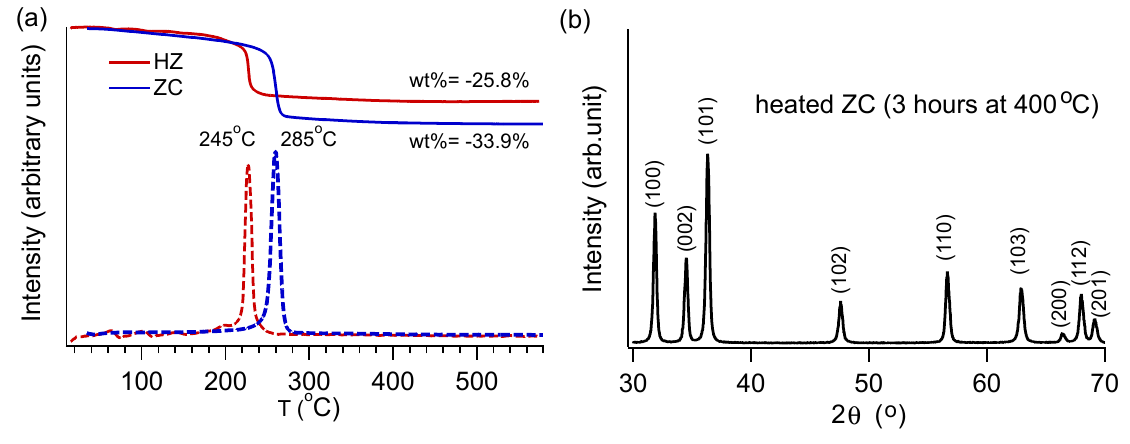
( a ) ZnCO (ZC, blue) and Zn (CO ) (OH) (HZ, red) show one-step 3 5 3 2 6 decomposition toward the formation of ZnO. The mass loss curves are shown as solid lines, and their derivatives are shown as dashed lines; ( b ) The decomposition products match ZnO (JCPDS 36-1451). The representative data shown here are for the product from ZC